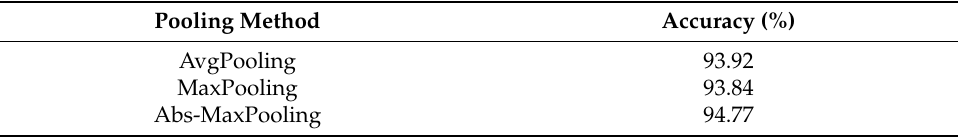
Table 5. Effects of using different pooling